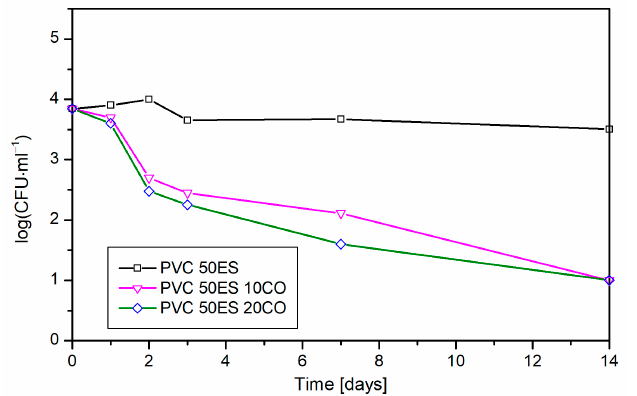
Figure 11. In fl uence of cassia oil concentration in PVC material on the growth of L. monocytogenes present on a spinach leaf.